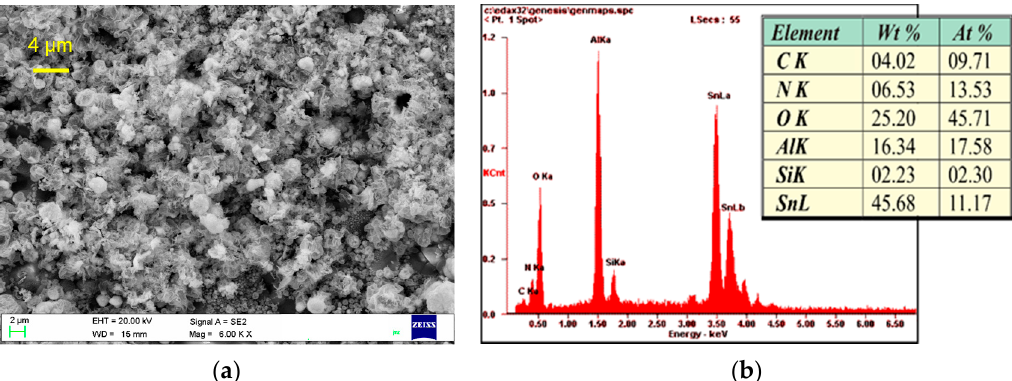
Figure 6. ( a ) SEM image of the RGTO-SnO 2 film surface (6000×) (Sn deposited on alumina substrate at 270 ℃ ) and ( b ) results of (SnO 2 ) microanalysis (qualitative and quantitative analysis).